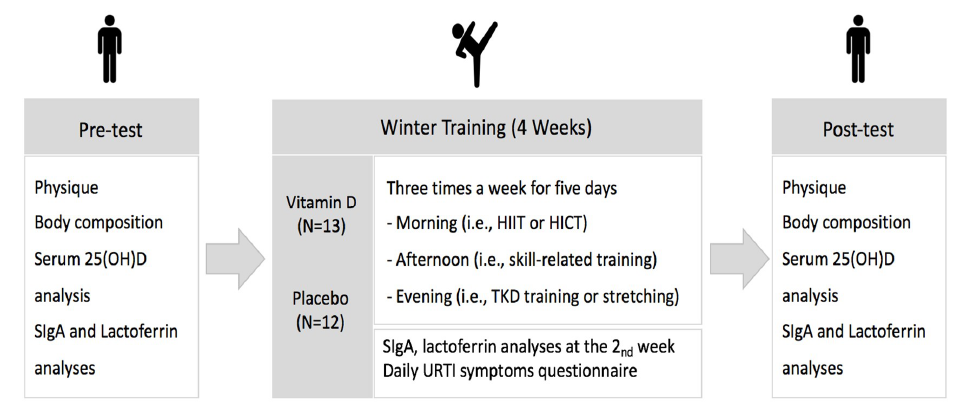
Figure 1. Study procedure note. HIIT: high intensity interval training, HICT: high intensity continuous training, SIgA: secretory immunoglobulin A, URTI: upper respiratory tract infection.